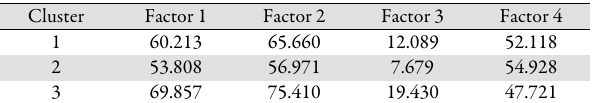
Table 6. The average of traits for achieved groups from cluster analysis, based on factor analysis in 20 spring wheat cultivars under normal irrigation